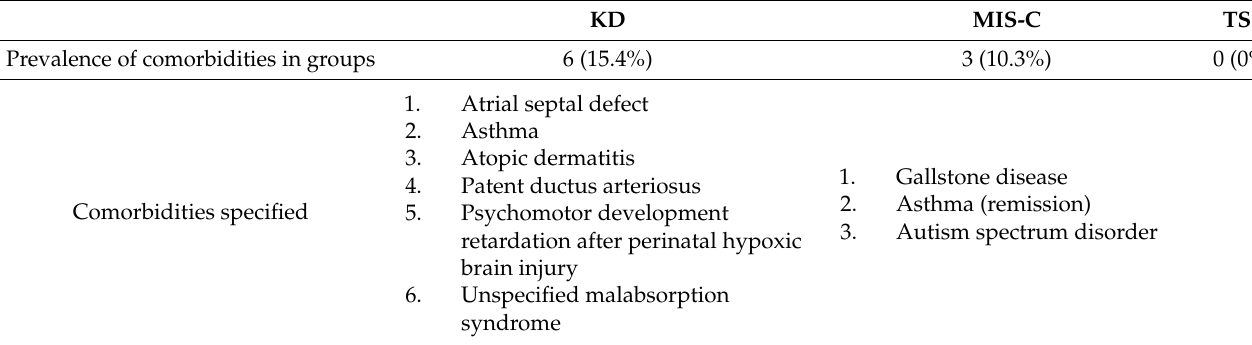
Table 1. Pre-existing comorbidities among research groups.